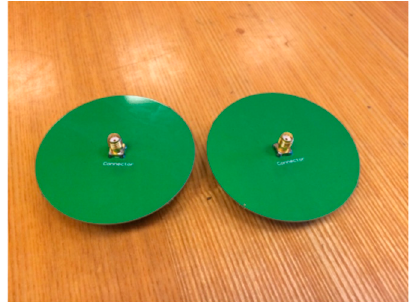
Figure 20. Two manufactured disc antennas used for on-body propagation loss measurements.